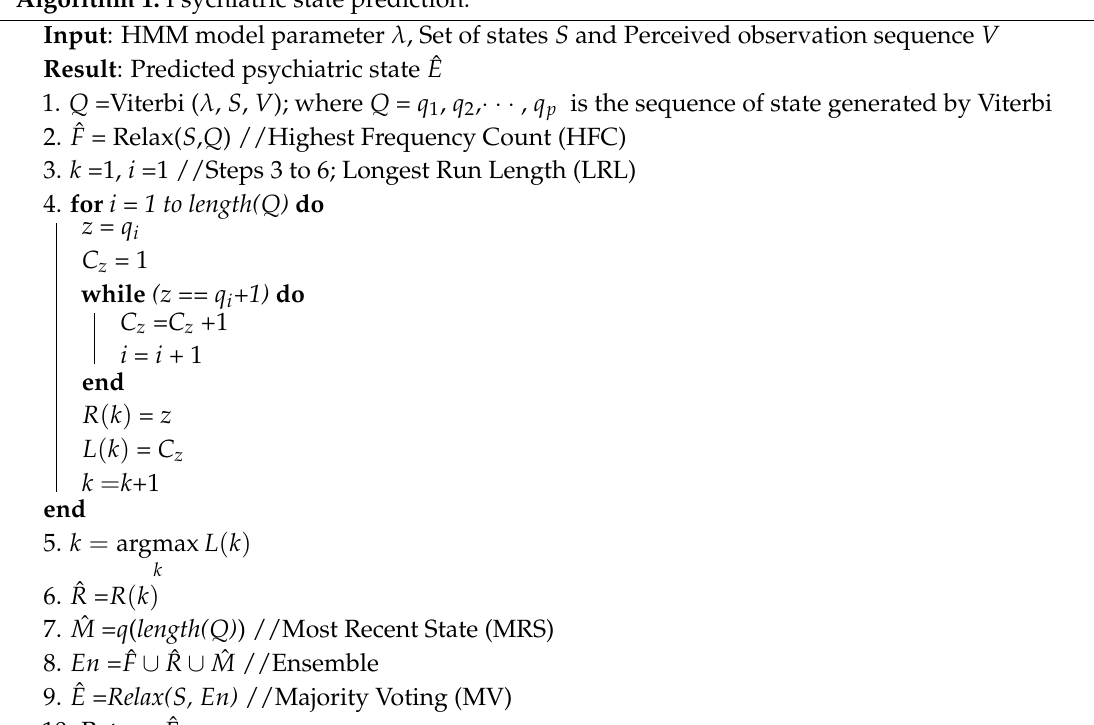
Algorithm 1: Psychiatric state